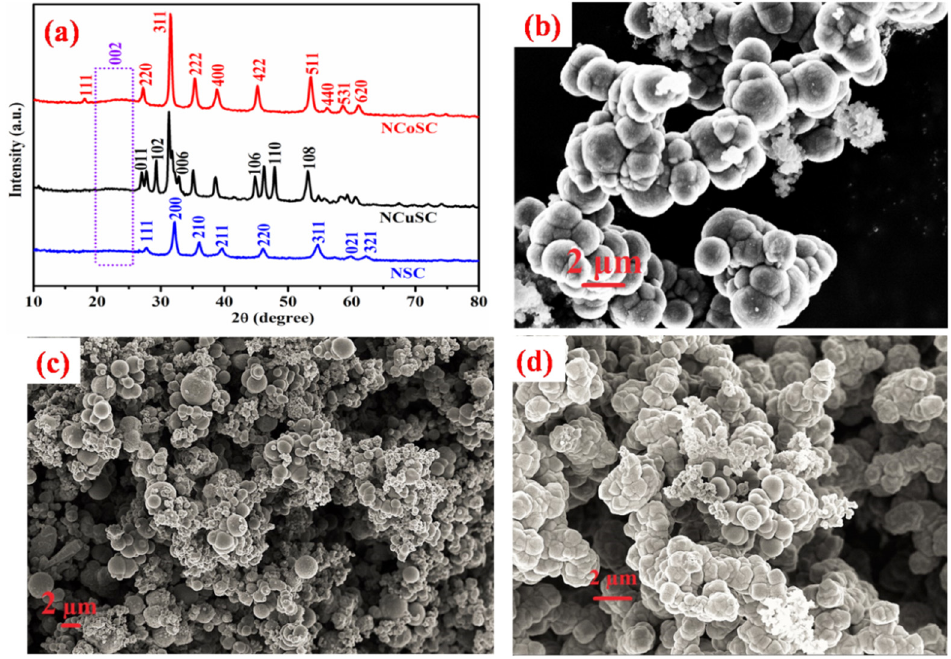
Figure 1. ( a ) PXRD pattern of NSC, NCuSC, and NCoSC electrodes, ( b – d ) FESEM images of NSC, NCuSC, and NCoSC electrodes, respectively.